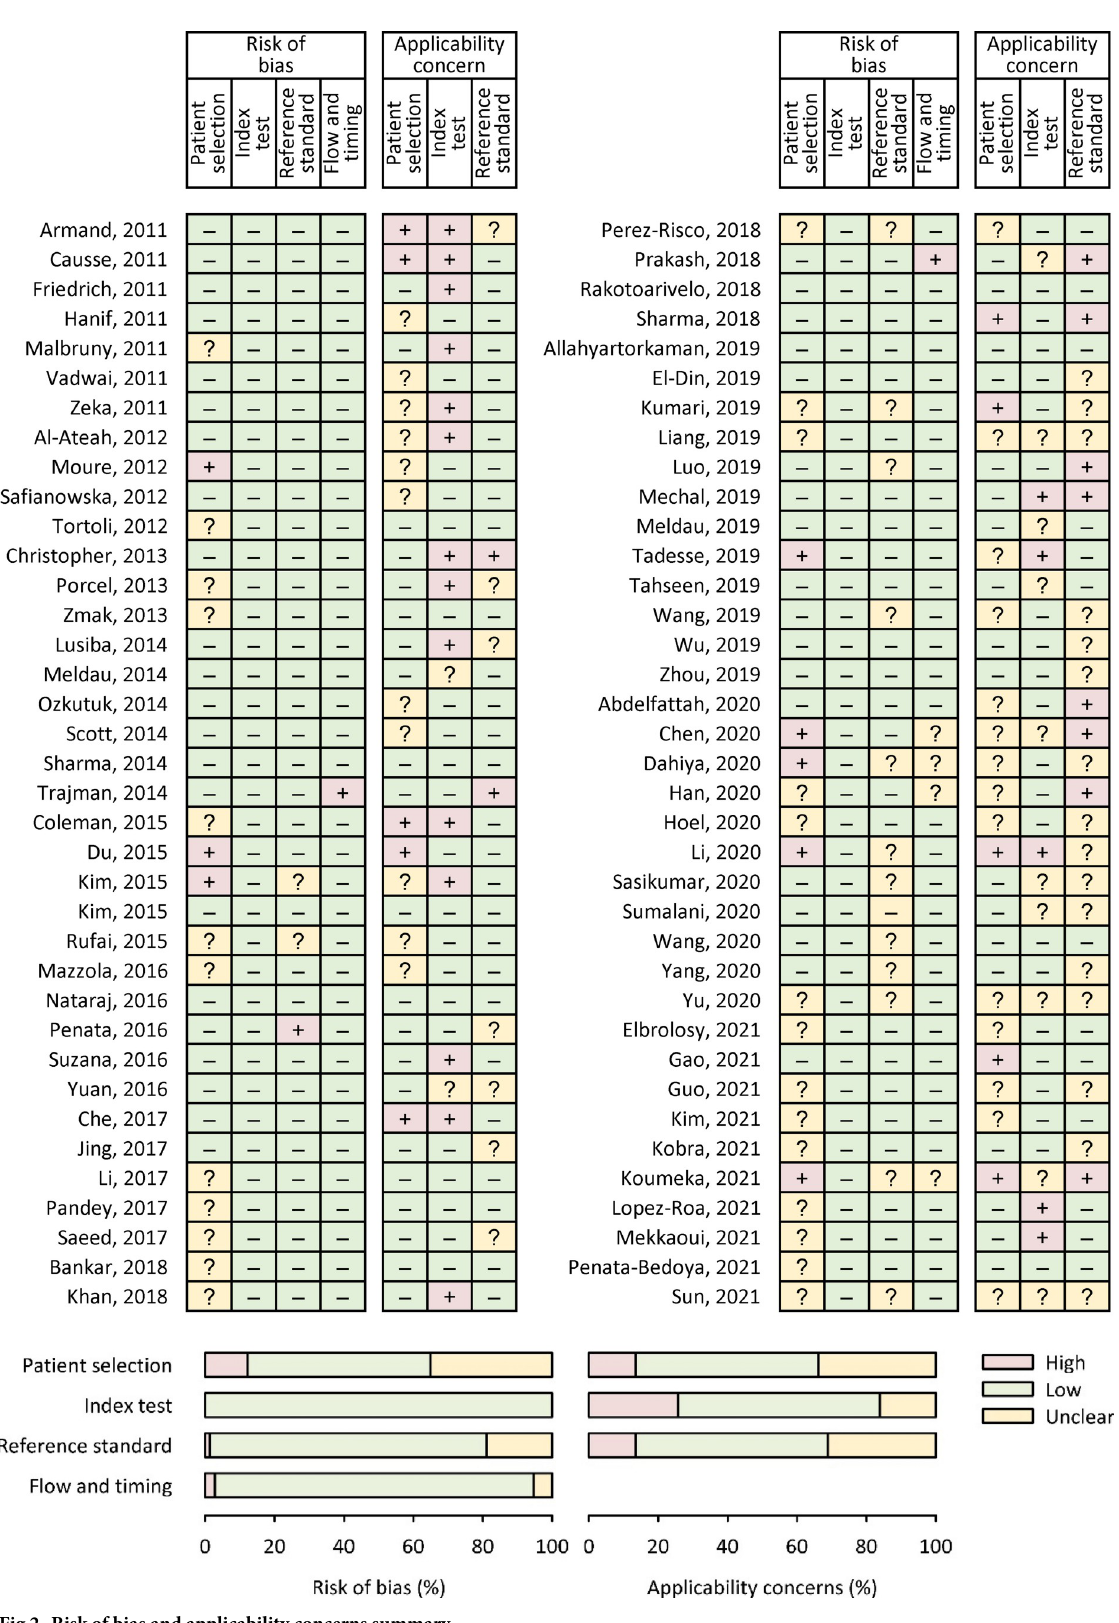
Fig 2. Risk of bias and applicability concerns